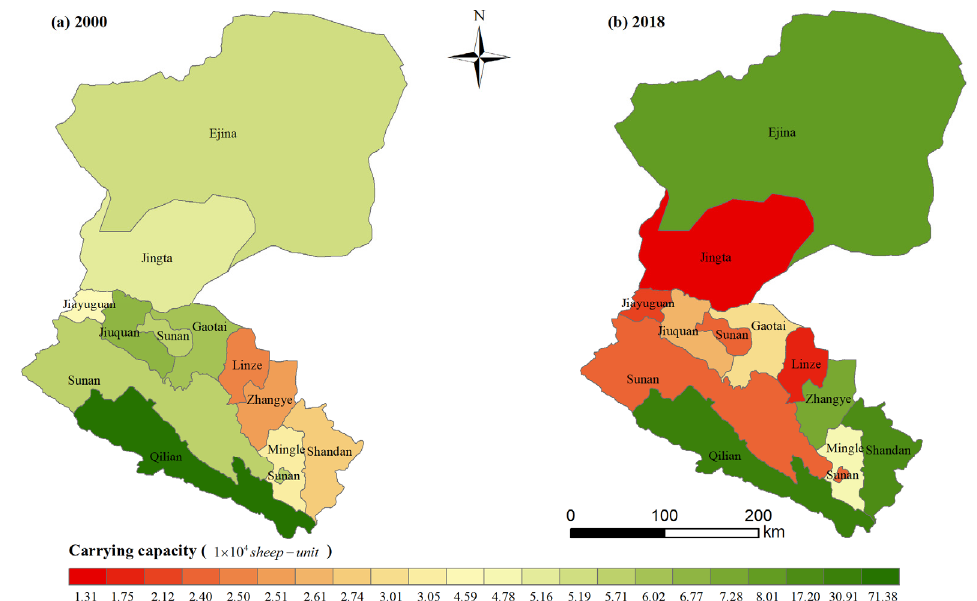
Figure 11. Spatial distribution of the carrying capacity in ( a ) 2000 and ( b ) 2018.